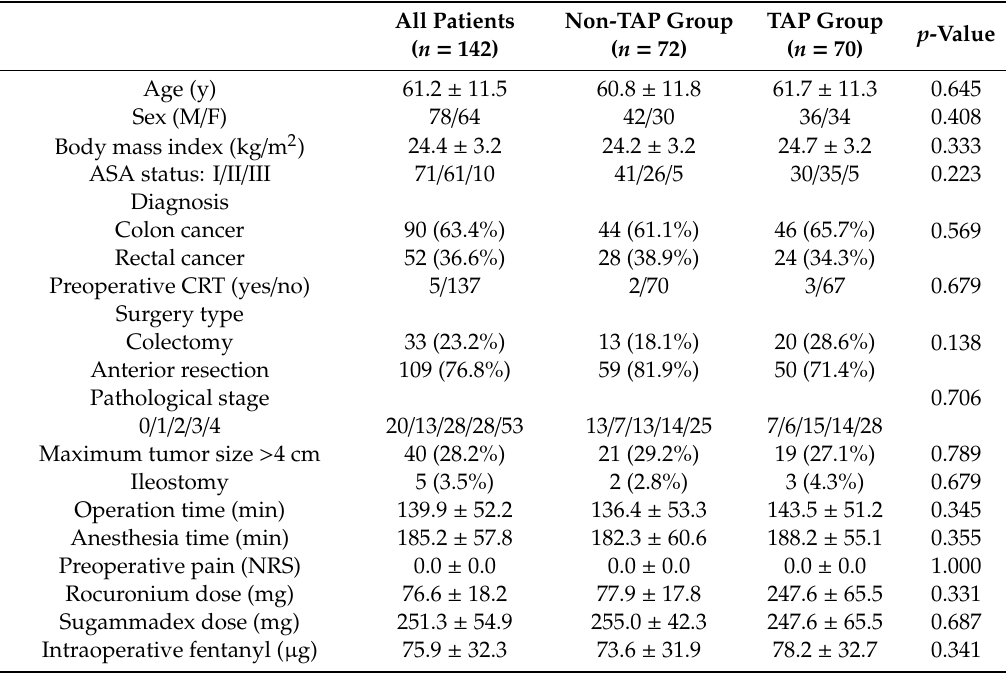
Table 1. Demographic and clinical characteristics. All Patients